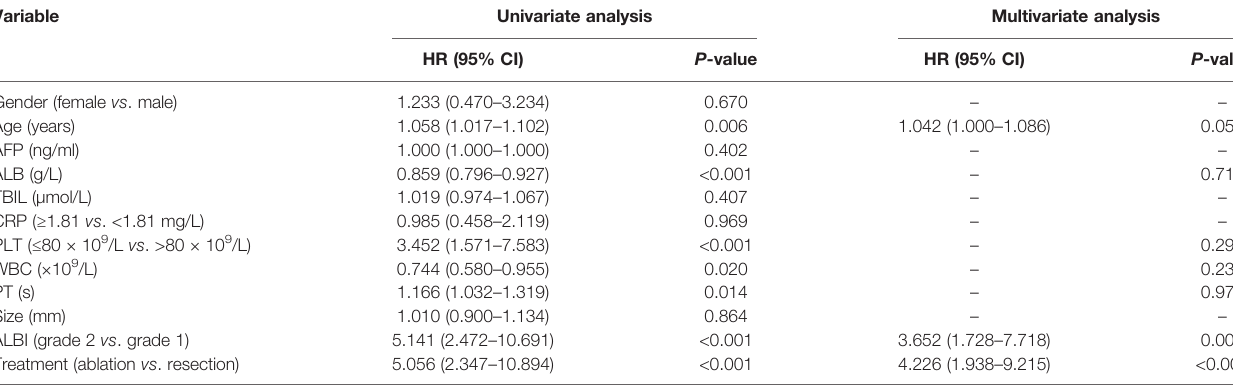
TABLE 7 | Univariate and multivariate analyses of overall survival (OS) in the entire cohort. Variable